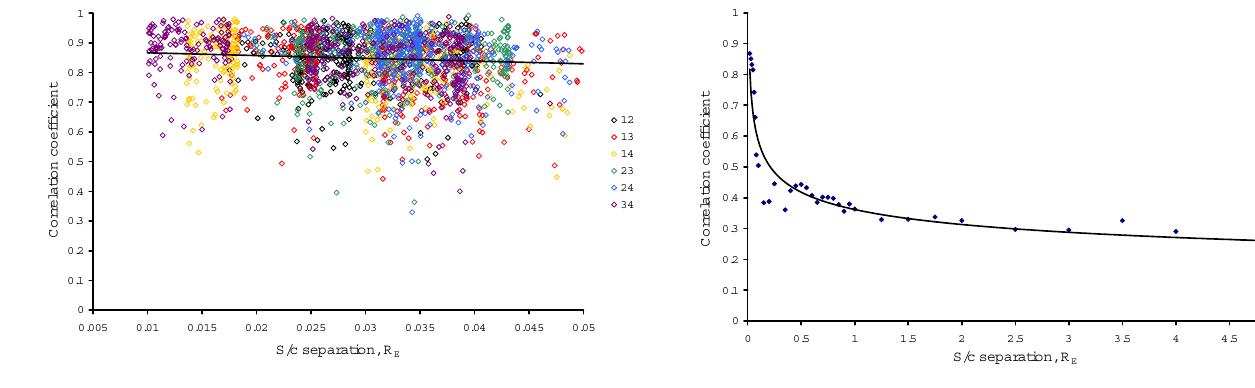
Fig. 7. Cross-correlation coefficients as a function of the s/c sepa- ration. Only the separations shorter than 0.05 R E are displayed, the different colors denote a spacecraft pair (see a legend on the right side of the figure).